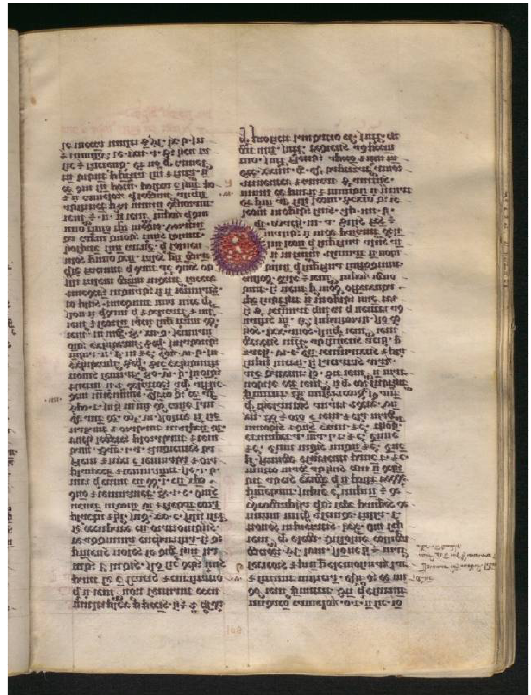
Figure 7. The wounded pages of the MS C317 from Vadstena have been decorated with silk thread in different colours: red, purple, green, yellow, and blue, to illustrate the wounds afflicted on the body of Christ. MS C317, fol. 8r. Uppsala Universitetsbibliotek.